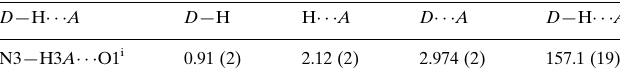
Hydrogen-bond geometry (A˚ , (cid:2)